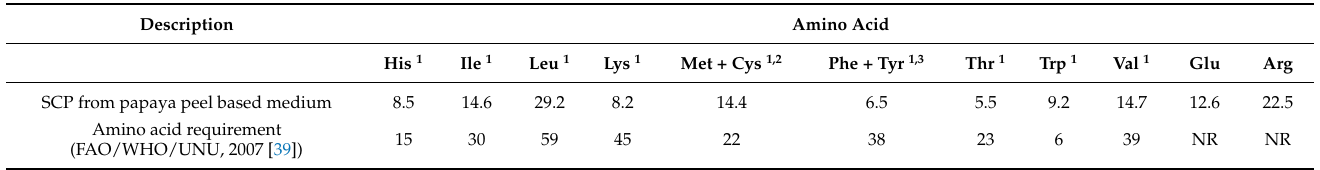
Table 5. Comparison of amino acid composition of SCP produced on papaya peel based medium with amino acid